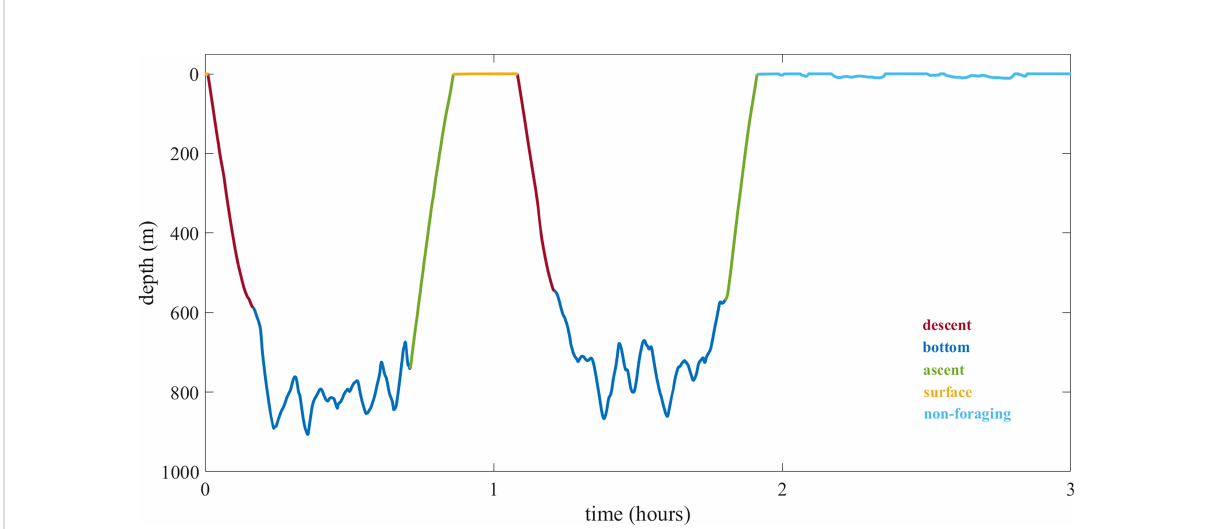
FIGURE 1 Example of foraging dive phases and a non-foraging period: descent (dark red), bottom (dark blue), ascent (green) and surface (orange) phases, and a non-foraging period (light